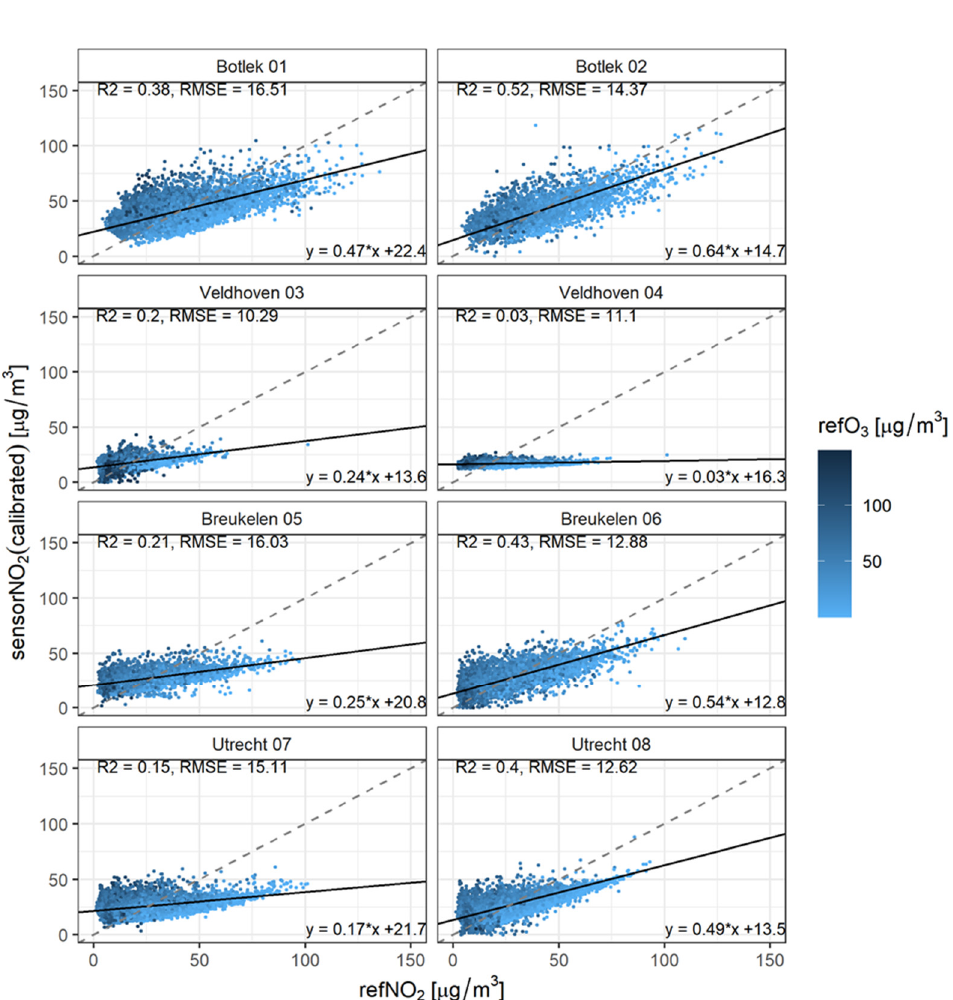
Figure 3. Scatter plots for concentration prediction by single linear calibration. The dot colors correspond to ambient O 3 concentration. The dashed line represents Y = X; the solid line follows from the orthogonal fitting between the calibrated sensor and reference concentration data.